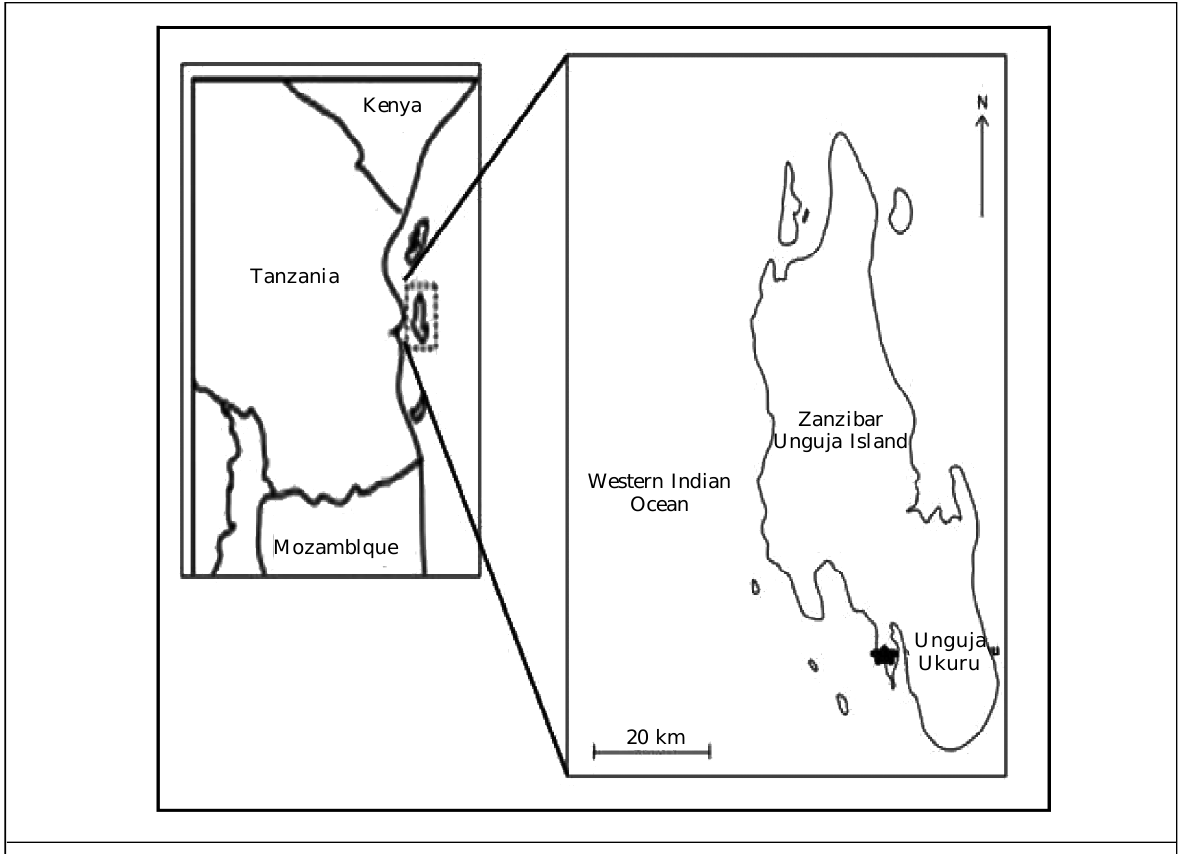
Figure 1: Map of Zanzibar Island, Tanzania showing study